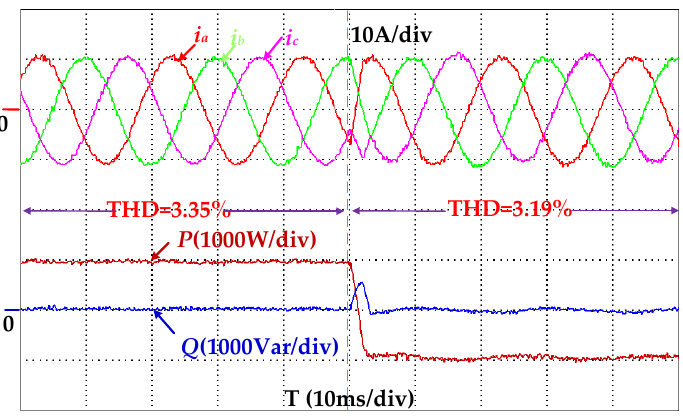
Figure 14. Dynamic experimental results of transition between inverter and rectifier mode with the proposed CF-MPDPC.